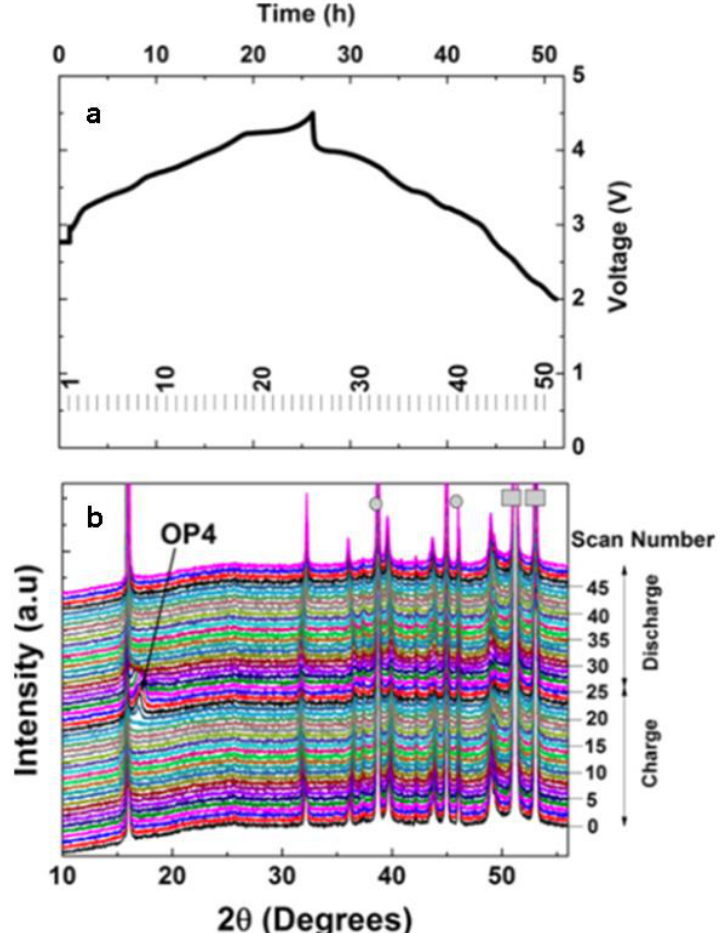
Figure 10. ( a ) Galvanostatic first charge-discharge curves. ( b ) In-situ X-ray diffraction of Na 0.67 Ni 0.2 Mg 0.1 Mn 0.7 O 2 showing the reversible evolution of P2 to OP4 phase transition at the end